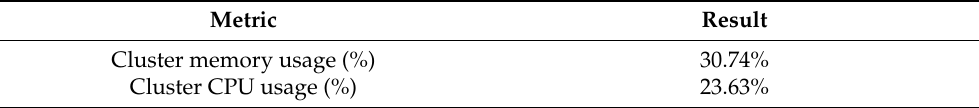
Table 13. Sysdig cluster metrics